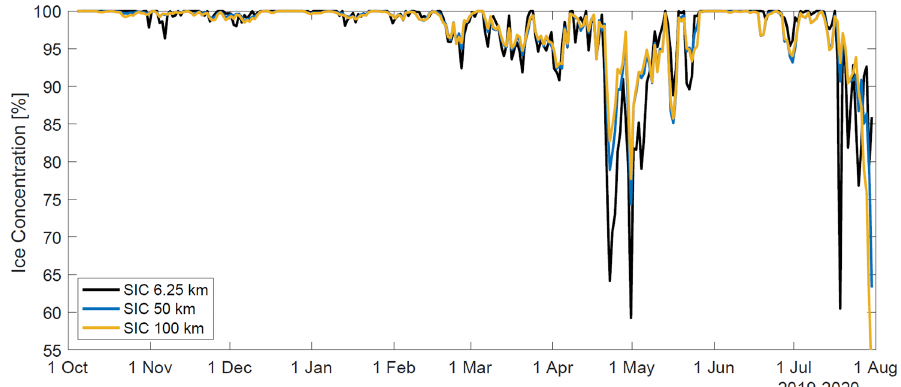
Figure 10. Sea ice concentration along the MOSAiC drift trajectory from the start of the drift on 4 October 2019 until the end of the first floe on 31 July 2020. Daily (no smoothing) sea ice concentrations are shown at 3.125 (black), 50 (blue) and 100km (yellow) radii. Note the significantly underestimated concentrations between mid-April to May and the associated discussion in the main text and Fig. 9.